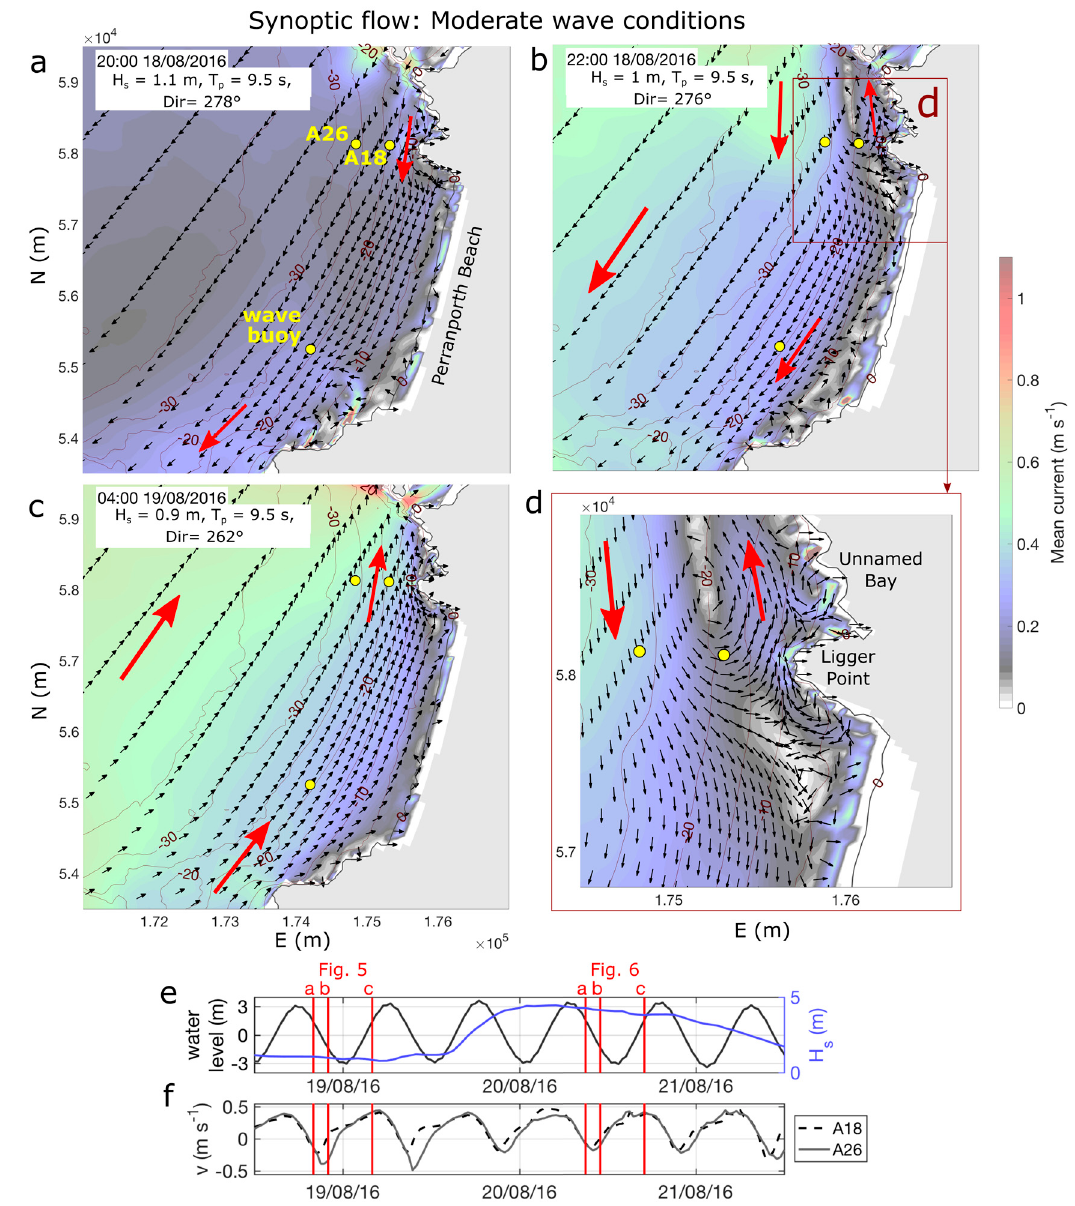
Figure 5. Synoptic snapshots (30-min averages) of simulated flow during moderate wave conditions. ADCP and wave buoy locations are indicated with yellow dots in ( a – d ). ( d ) is a magnified inset of ( b ), with a higher resolution of current vectors indicated. The black arrows in ( a – d ) indicate direction, not magnitude; the red arrows are interpretations of primary currents. A timeseries of water level and wave height ( e ) and alongshore velocity ( f ) are provided with snapshot times for Figures 5a–c and 6a–c, indicated by red lines.